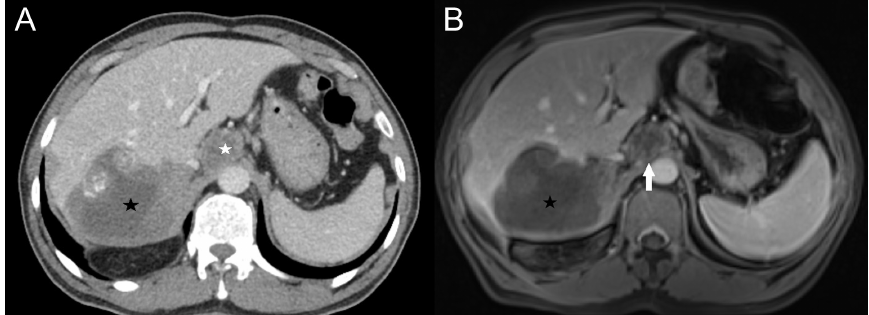
Figure 2. A,B. Axial contrast-enhanced computed tomography (CT) (A) and T1-weighted contrast- enhanced image (B) show alveolar echinococcosis lesions located in the liver (black stars) and anterior to the aorta (white star). Note that the liver lesion is of heterogeneous density and contains areas of hyperdense that may represent calcification in CT image (A). On magnetic resonance imaging (B), the lesion observed adjacent to the aorta is seen to invade the diaphragm (white arrow).